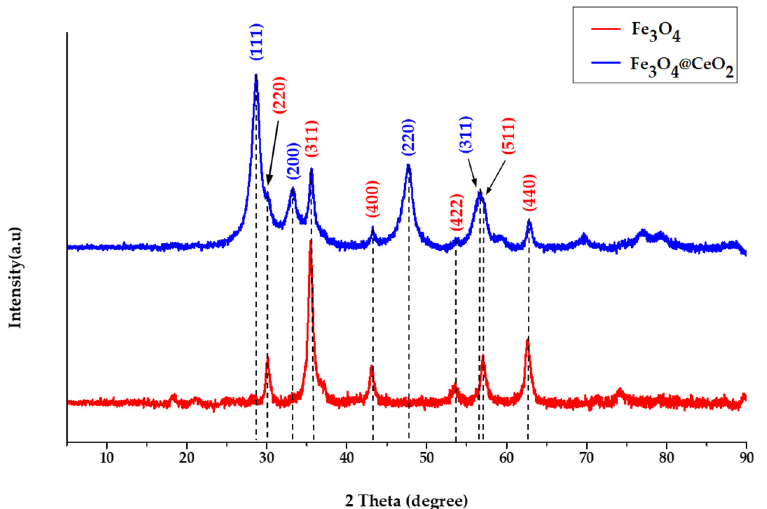
Figure 3. X-ray Diffraction (XRD) patterns of co-precipitated Fe 3 O 4 and synthesized Fe 3 O 4 @CeO 2 .